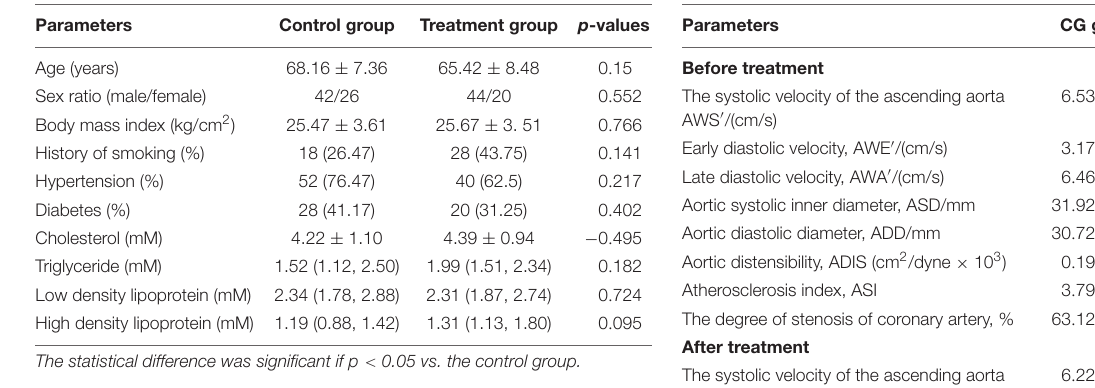
TABLE 3 | Ascending aortic elasticity.